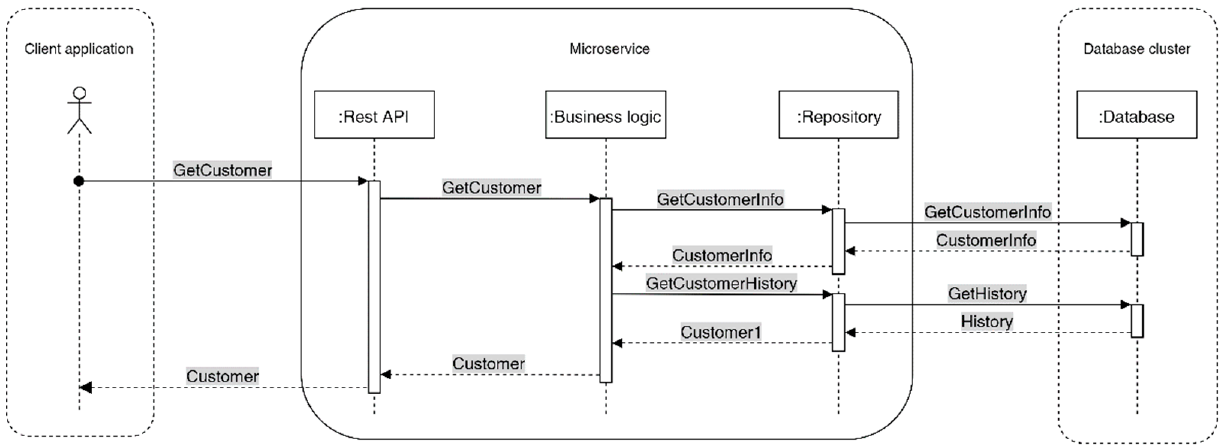
Figure 4. An example of the function GetCustomer implementation within the microservice layers.